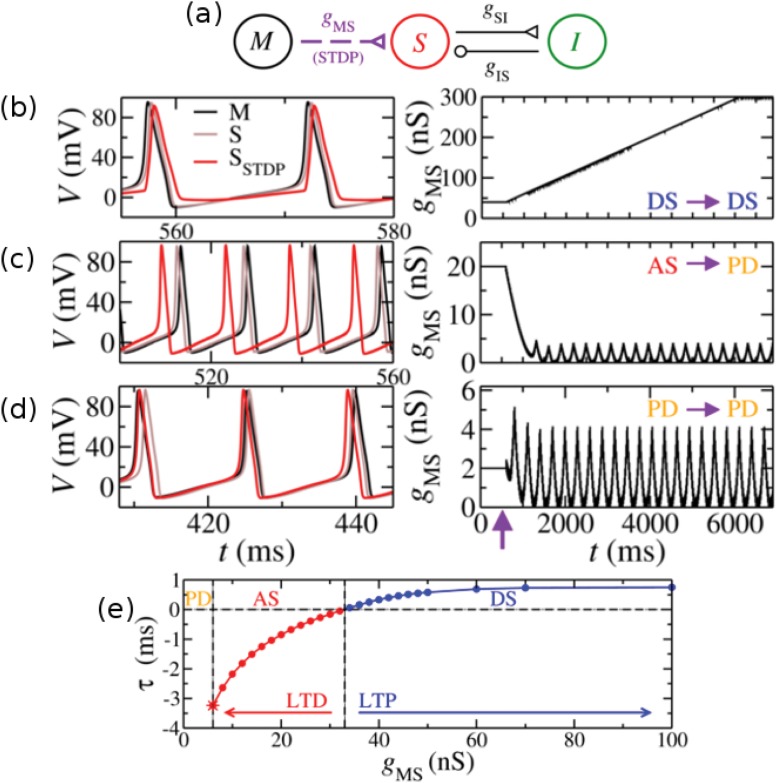
STDP in a microcircuit of three neurons.(a) Three neurons coupled by chemical synapses in the master-slave-interneuron (MSI) configuration. The excitatory synaptic weight g
MS may change through STDP rules. (b)-(d) Left: membrane potential of the master (M, black), the slave with no plasticity (S, grey) and the slave with STDP (SSTDP, red). Right: The synaptic weight g
MS as a function of time. The vertical arrow indicates the moment at which plasticity rules were switched on. The system can exhibit synchronized regimes with positive time delay (delayed synchronization, DS) or negative time delay (anticipated synchronization, AS) and a phase-drift (PD) regime. (b) The system initiates in the DS regime and remains in it. The synaptic weight increases from the initial value to the upper boundary. (c) The system initiates in the AS regime, then g
MS decreases to values smaller than 6 nS and the phase-drift (PD) regime is reached. (d) The system initiates in the PD regime and ends in a different PD regime. (e) Without STDP, the time delay τ between M and S is a smooth function of the weight g
MS. If we turn on STDP, the DS region (g
MS > 32 nS) leads to LTP whereas the AS region (6 < g
MS < 32 nS) leads to LTD. For g
MS < 6 nS the system exhibits a PD regime.